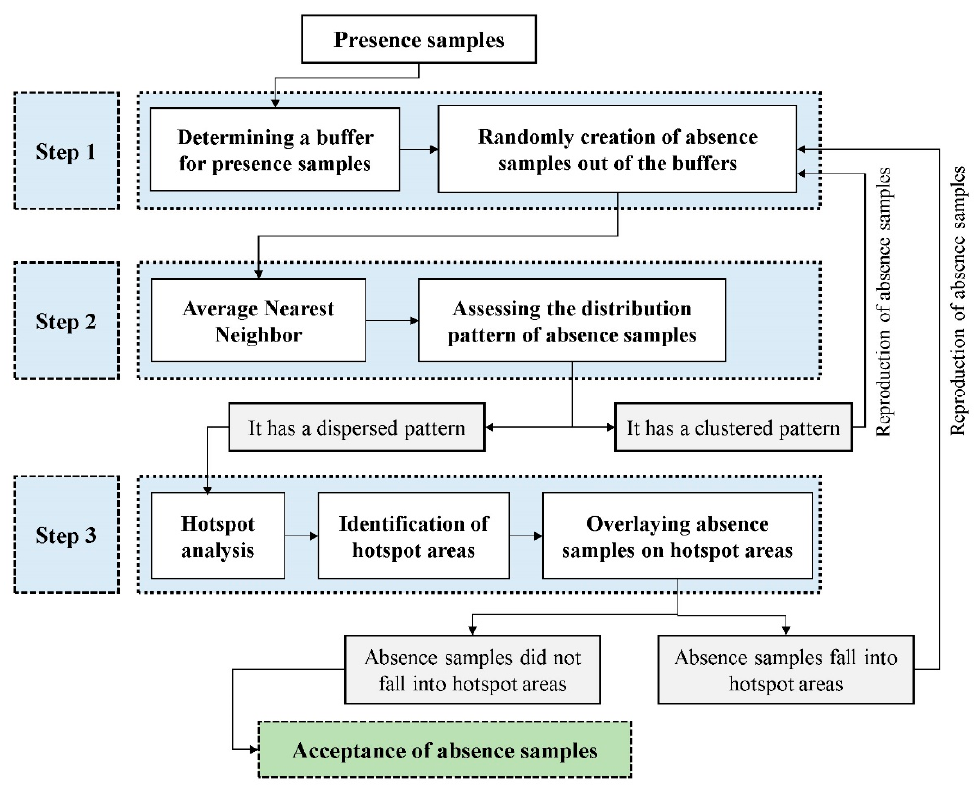
Figure 1. A conceptual architecture (processing steps) for generating absence samples by the Selection of Absence Samples (SAS) tool.